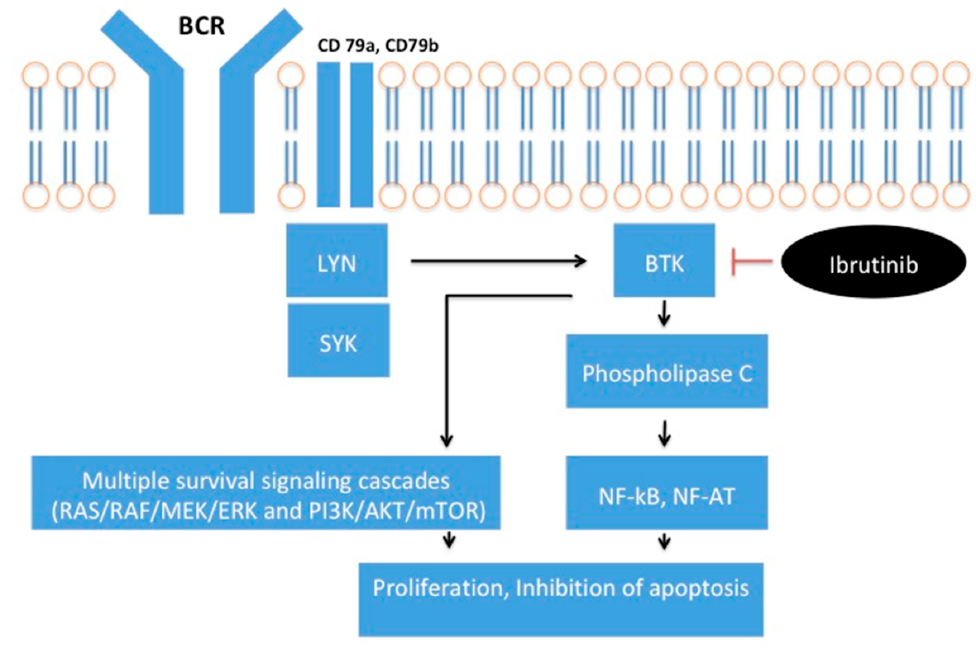
Figure A1. Simplified diagram of effects of BCR pathway activation. BCR activation leads to BTK plasma membrane translocation and phosphorylation by members of the Src kinases (e.g., LYN, SYK). Induction of BTK triggers activation of phospholipase C and calcium mobilization. This leads to downstream events such as proliferation and differentiation mediated through multiple transcriptions factors (NF- κ B, NF-AT) and survival signaling cascades (RAS/RAF/MEK/ERK and PI3K/AKT/mTOR). Ibrutinib binds to BTK to inhibit BTK signaling.